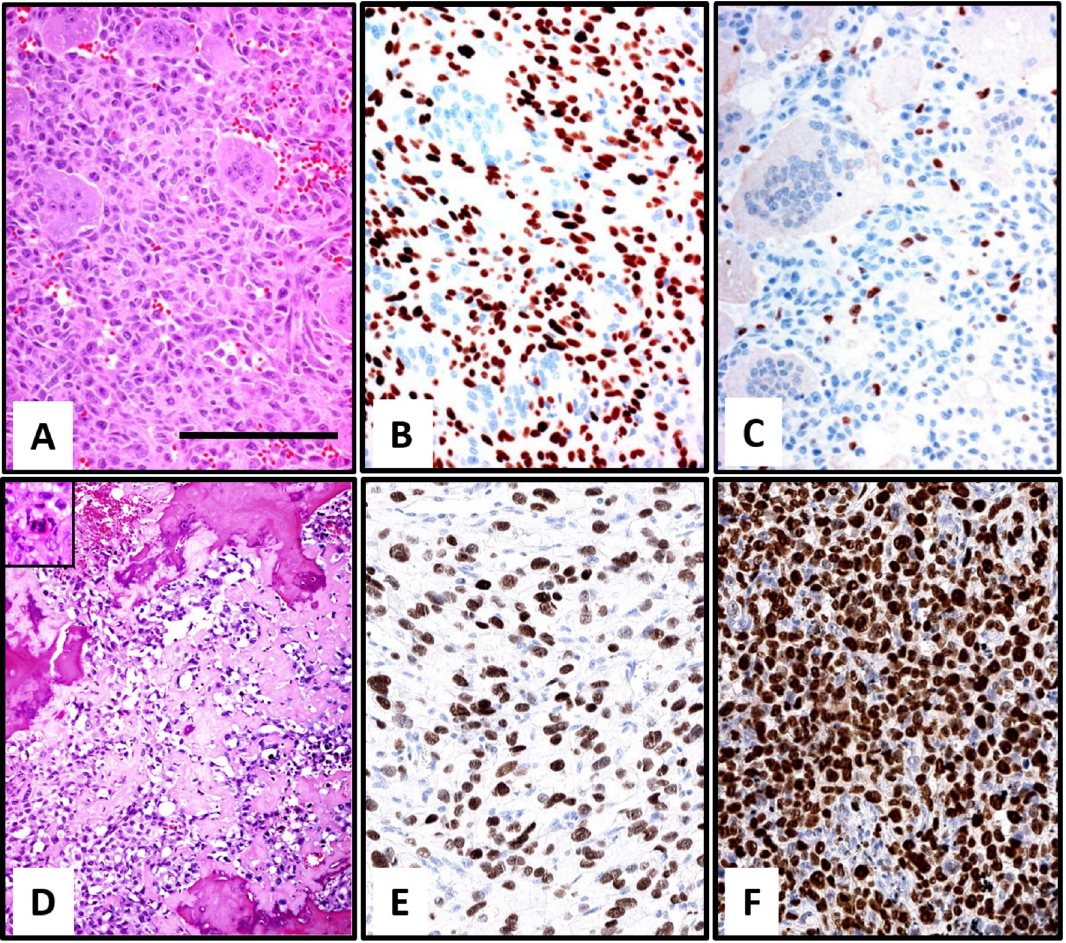
Figure 2. Morphology of Case 2. Typical morphology of GCTB with osteoclastic giant cells and mononuclear spindle cells (A) neoplastic mononuclear cells with positive H3F3A G34W staining (B) (bar = 100 µm). Staining for Ki-67 shows about 5% positive cells (C) . The sarcoma showed presents with polymorphic tumor cells andatypical mitotic figures with necrosis intermingled lace-like neoplastic osteoid intermingled with necrotic bone. An atypical mitotic figure is shown in the insert (D) . The sarcoma harboured the H3F3A G34W mutation (E) and had a high rate of Ki-67 (F)